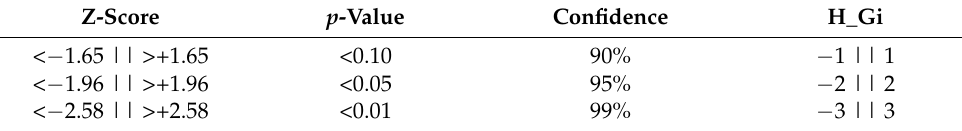
Table 2. The Correspondence between Z-score, p -value, Confidence, and the H_Gi value. Z-Score p -Value